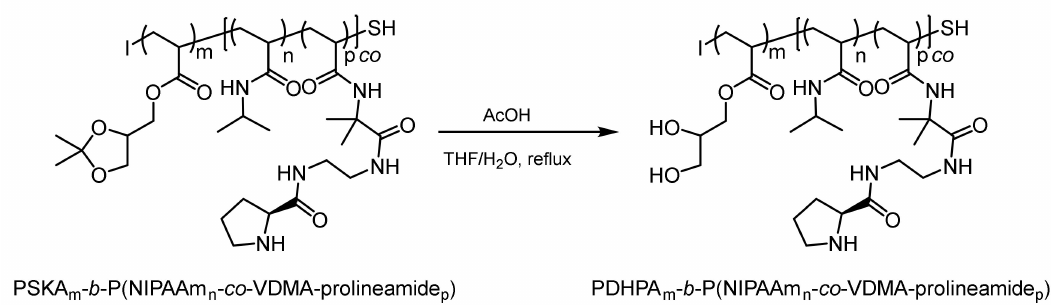
Figure 5. Deprotection of the solketal moiety affording the hydrophilic poly(2,3-dihydroxypropylacrylate) (PDHPA) block (AcOH = glacial acetic acid).